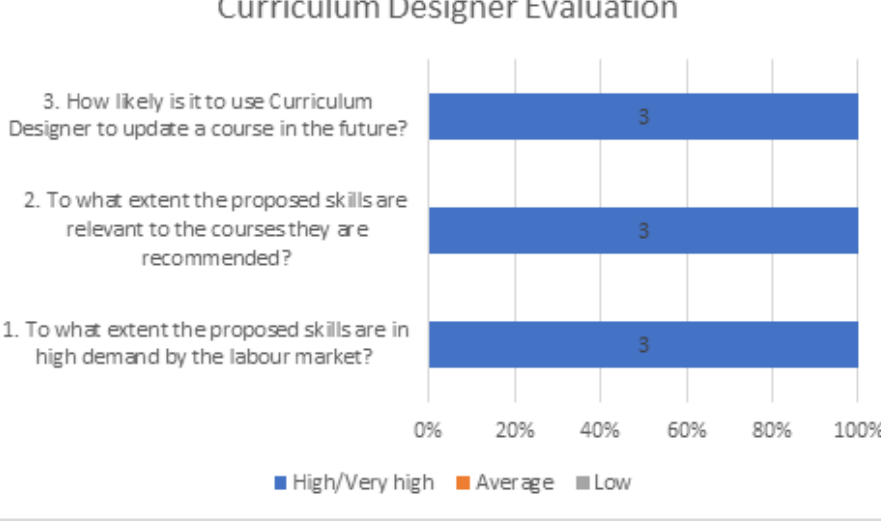
Figure 16. Curriculum Designer evaluation by professors.